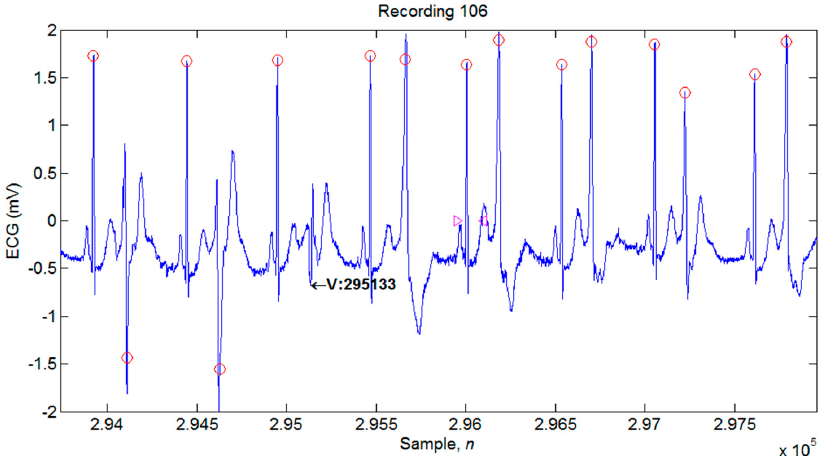
Figure 13. Illustration of the detection failures caused by greatly reduced amplitudes of QRS peaks compared to the adjacent QRS peaks.